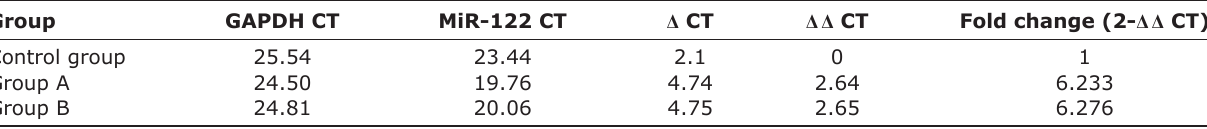
Table-4: Serum hepatocyte-derived miRNA-122